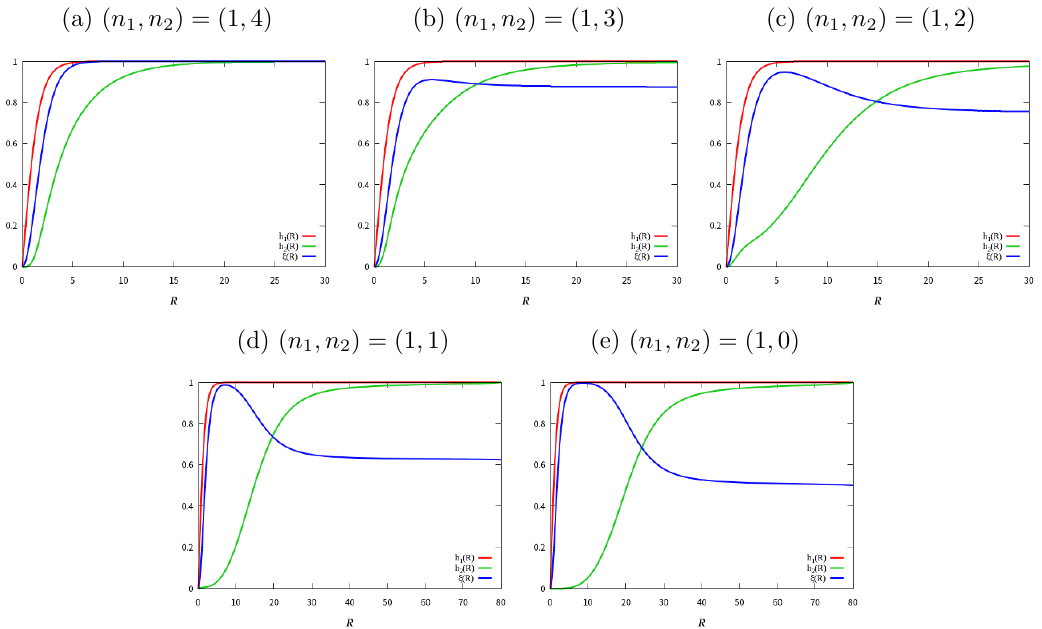
Figure 2. The static string solutions as a function of R for given winding numbers. In the (cid:12)gure, we take q 1 = 1 and q 2 = 4 and (cid:17) 1 =(cid:17) 2 = 4. The upper-left panel corresponds to the compensated string for N w = 1. The other strings are uncompensated strings. Note that the (cid:12)gures in the (cid:12)rst row are shown only up to R (cid:20) 30 to emphases the structures around the string core, while those in the second row is up to R (cid:20)